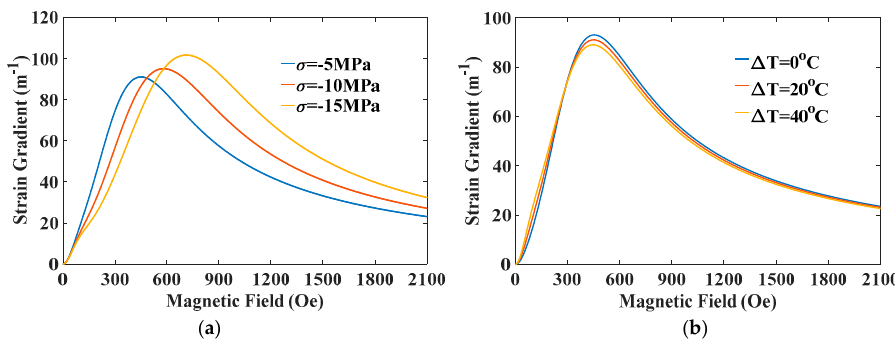
Figure 7. The strain gradient varied with magnetic field under different ( a ) stresses and ( b ) temperatures.